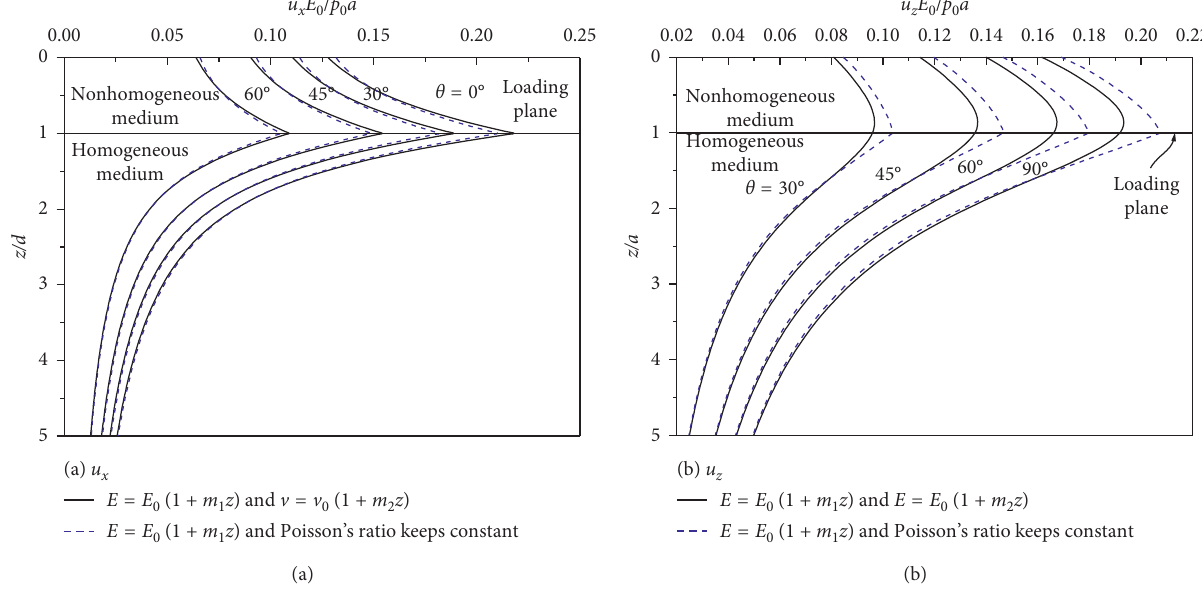
Figure 7: Variations of the displacements u